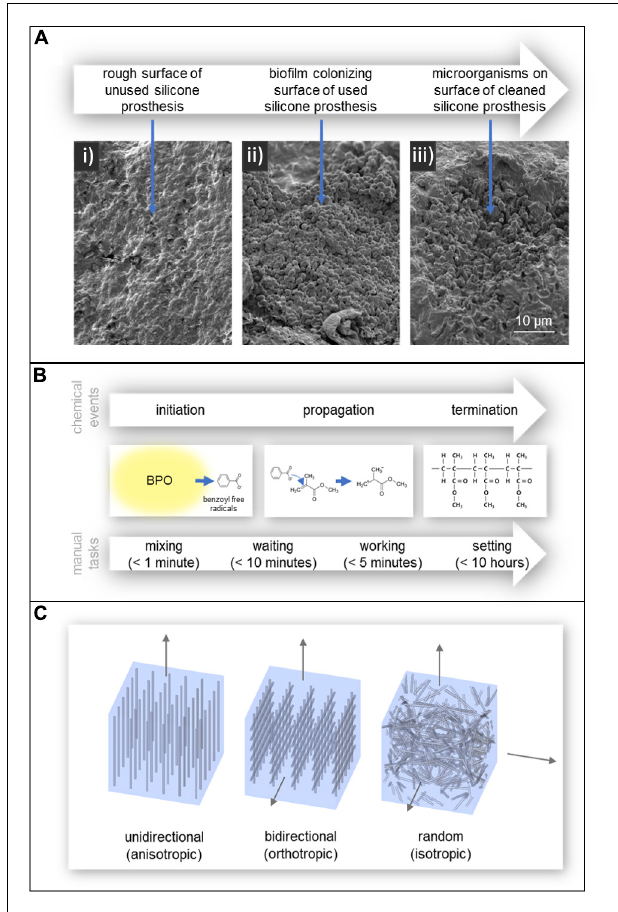
FIGURE 4 | (A) SEM images of (i) the rough surface of an unused silicone prosthesis, (ii) a biofilm colonizing the surface of a used silicone prosthesis, and (iii) microorganism remaining embedded in the defects of the prosthesis after cleaning. Reproduced from Taylor and Francis (Ariani et al., 2012). (B) Polymerization of acrylic resin and the manual tasks associated with working with autopolymerising acrylic resin. Times are according to manufacturer Factor II, Incorporated (Product Information - Heat Cured Acrylics, 2010). (C) Fiber reinforcement of acrylic resin; (left) unidirectional, (center) bidirectional, and (right) randomly